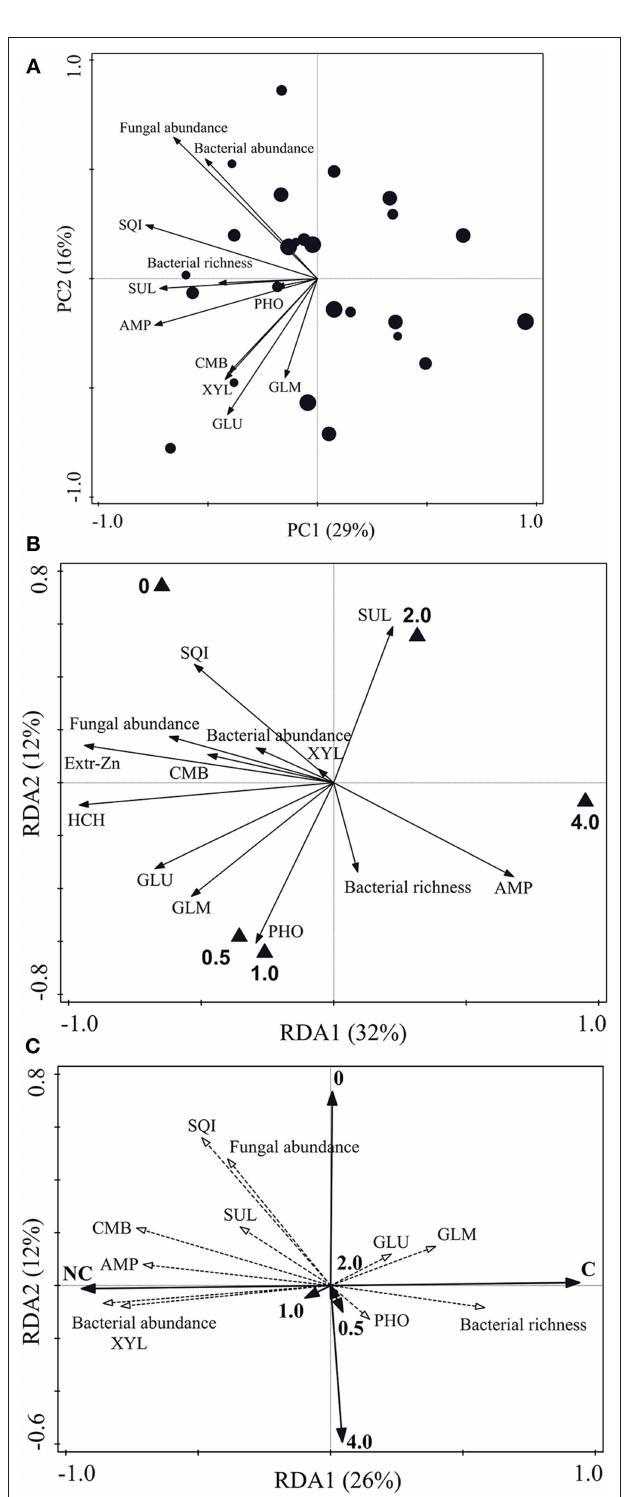
FIGURE 1 | Multivariate analyses of relationships between nZVI concentrations and microbial parameters. (A) PCA of non-contaminated soil: the larger the circle size, the higher the nZVI concentration (from 0 to 4mg g − 1 DW soil); (B) RDA of contaminated soil; (C) RDA of both non-contaminated (NC) and contaminated (C) soil. Abbreviations as in Table 1